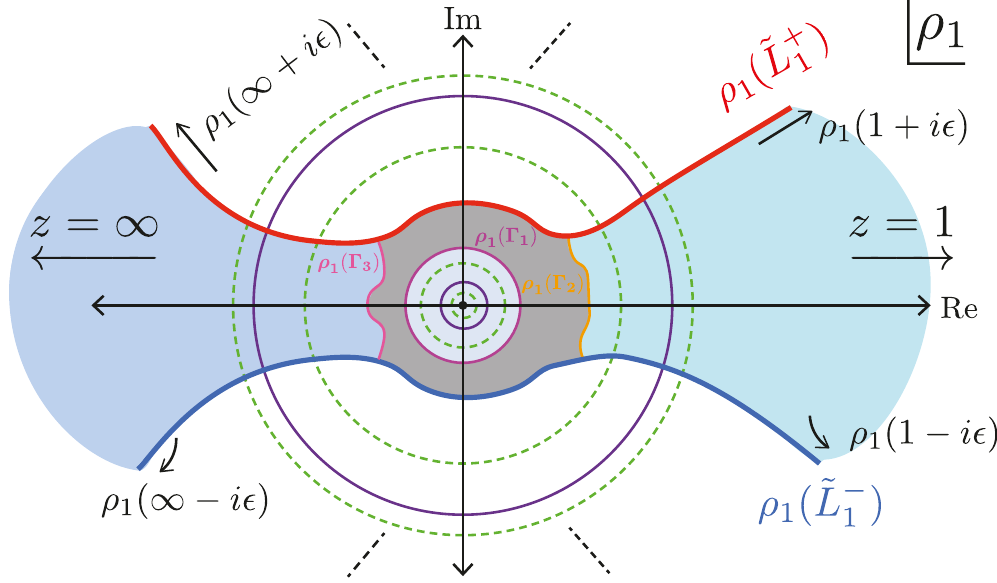
Figure 2 . The rough sketch of the geometry on the ρ 1 -plane. The meaning of the curves are explained in the text. The coloring conventions for the curves will be the same for all figures in this subsection. Dashed curves indicate the line singularities.